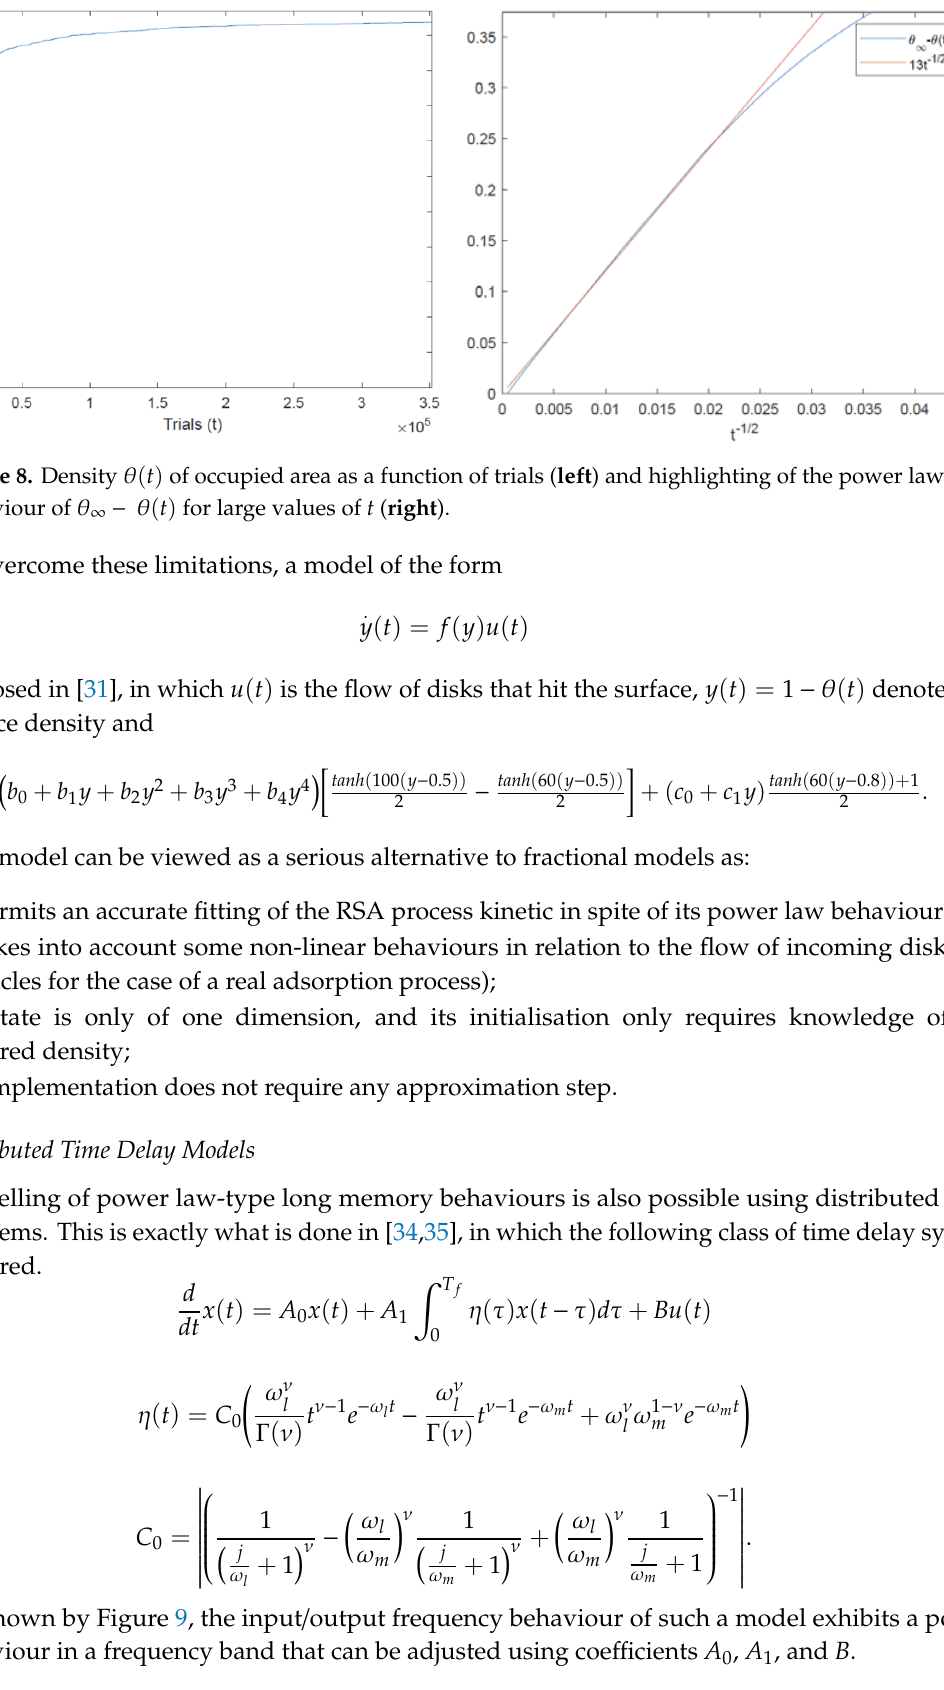
Figure 7. A possible result for the random sequential adsorption (RSA) process.